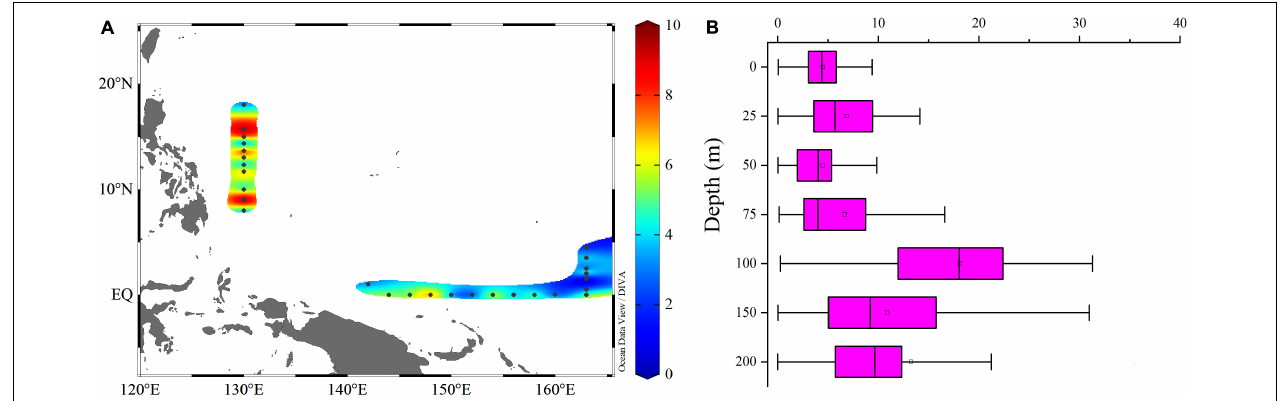
FIGURE 10 | Horizontal (A) and vertical (B) profiles of C:Chl a